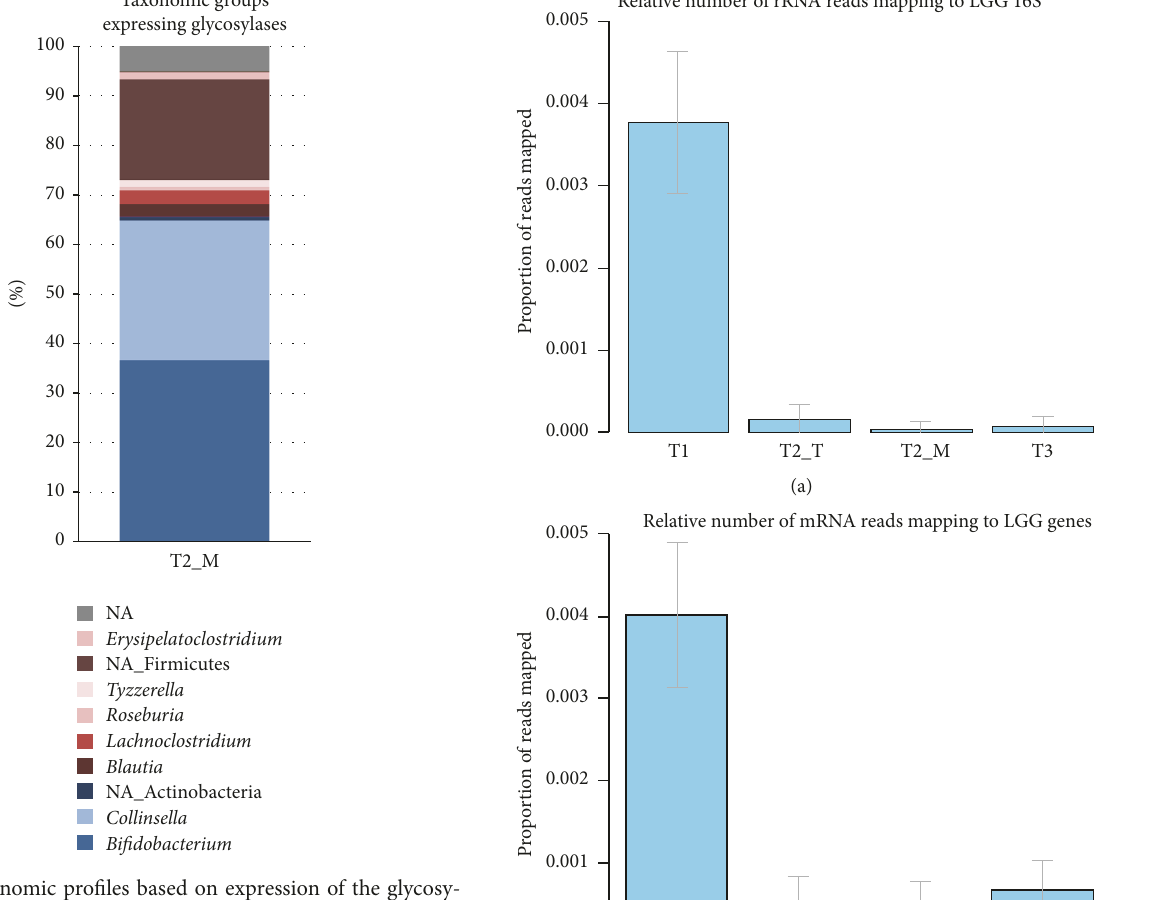
Figure 5: Taxonomic profiles based on expression of the glycosy- lases genes in sample T2 M.